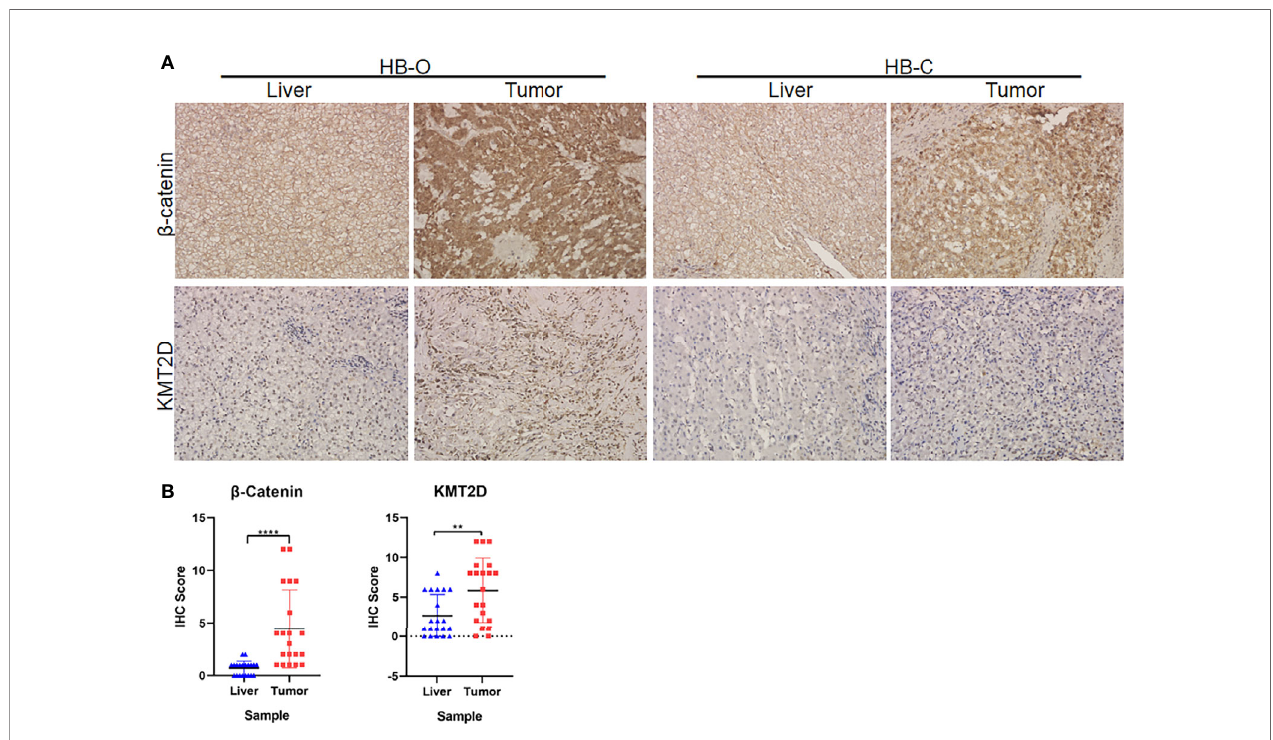
FIGURE 6 | Immunohistochemical (IHC) analyses of b -catenin and KMT2D in HB tumors. (A) Representative IHC images of b -catenin and KMT2D staining in two HB tumors and paracancerous normal liver tissues (HB-O and HB-C). Original magni fi cations, 200×. (B) Statistical analysis of the IHC staining of b -catenin and KMT2D proteins in 20 pairs of HB and paracancerous normal liver tissues from our center. The results showed that the expression levels of b -catenin and KMT2D in tumor tissues were signi fi cantly higher than those in normal liver tissues (**** P < 0.0001, ** P = 0.0057,